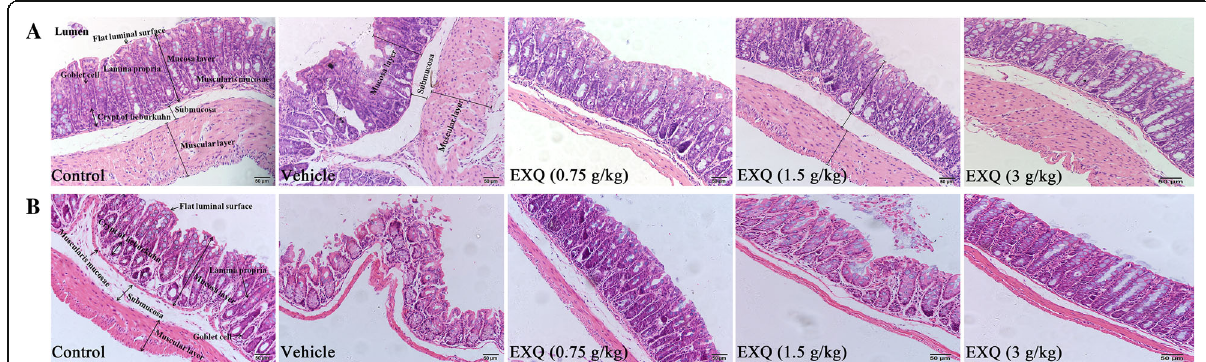
Fig. 6 Histological examinations for the possible protective effect of EXQ in two models of experimental constipated mice (Original magnification ×200). a HHPD model; b HHPD + atropine